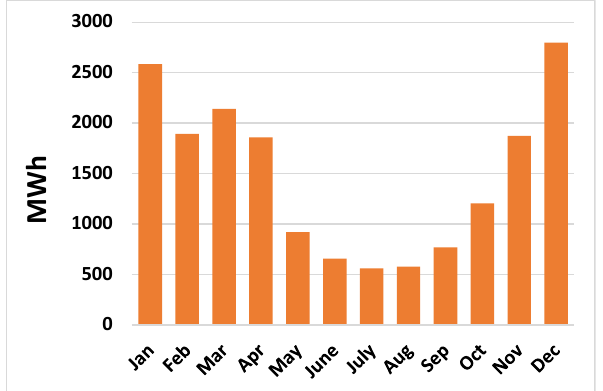
Figure 5. Monthly heating demand in load type L02.